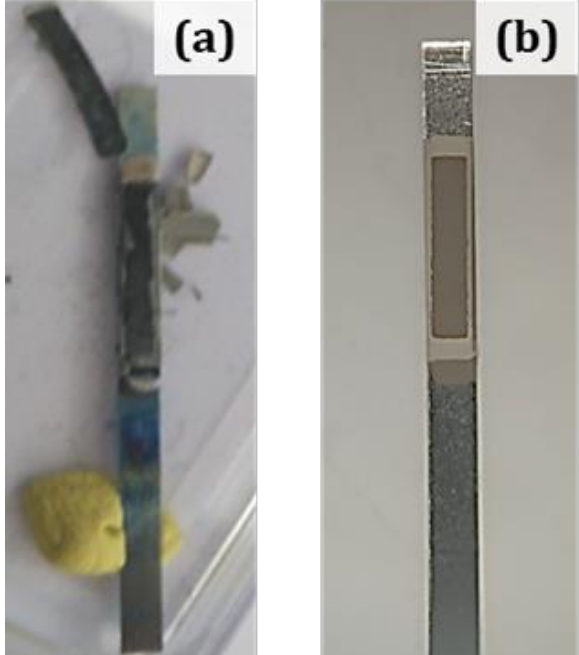
Figure 13. Samples obtained after SPS using Ag/Pd electrodes ( a ) with a 250 µm substrate thickness, resulting in destroyed samples, and ( b ) with a 100 µm substrate thickness, resulting in samples with good adhesion.